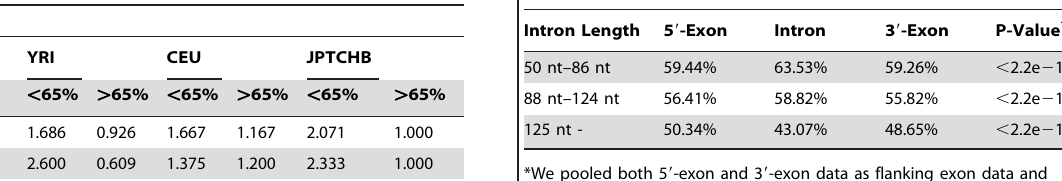
Table 4. Median GC contents in variable intron size intervals and